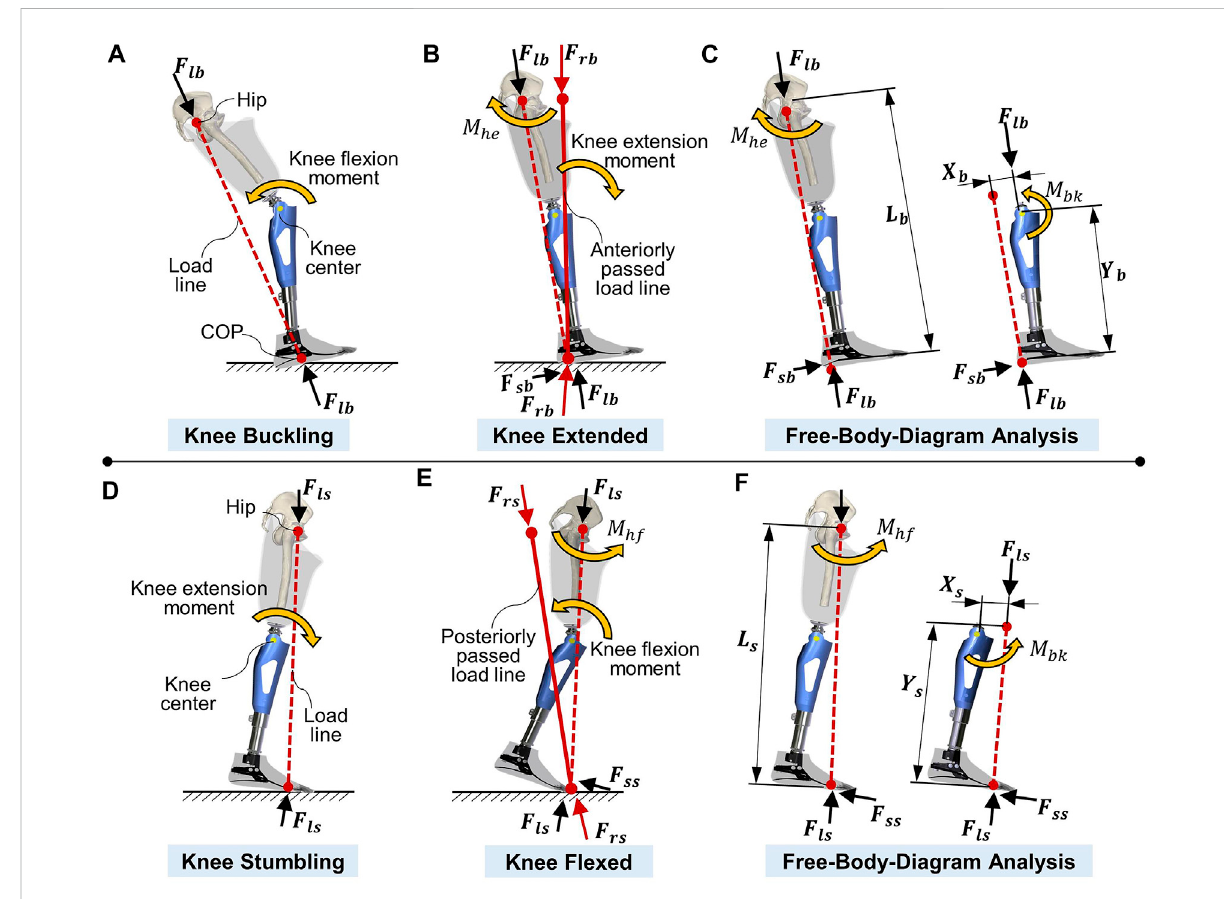
FIGURE 3 Prosthetickneeatearly-stanceandlate-stance. (A) Kneebucklingwithloadline(dashline)passesposteriorlytothekneecenteratearly-stance. (B) Knee stabilizes by the hip extension moment with load line transfers anteriorly (solid line) to knee center. (C) Free body diagram (FBD) analysis of theminimumhipmomentrequiredforthekneestabilization. (D) Kneestumblingwithloadline(dashline)passesanteriorlytothekneecenteratlate- stance. (E) Knee stabilizes by the hip fl exion moment with load line transfers posteriorly (solid line) to knee center. (F) FBD analysis of the minimum hip moment required for the knee fl